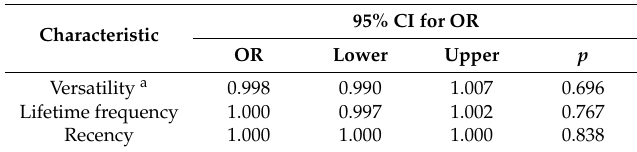
Table 1. Binary logistic regression exploring whether versatility of methods, lifetime frequency, and recency of self-injury predict self-injury group (NSSI vs. NSSI + SB). 95% CI for OR Characteristic